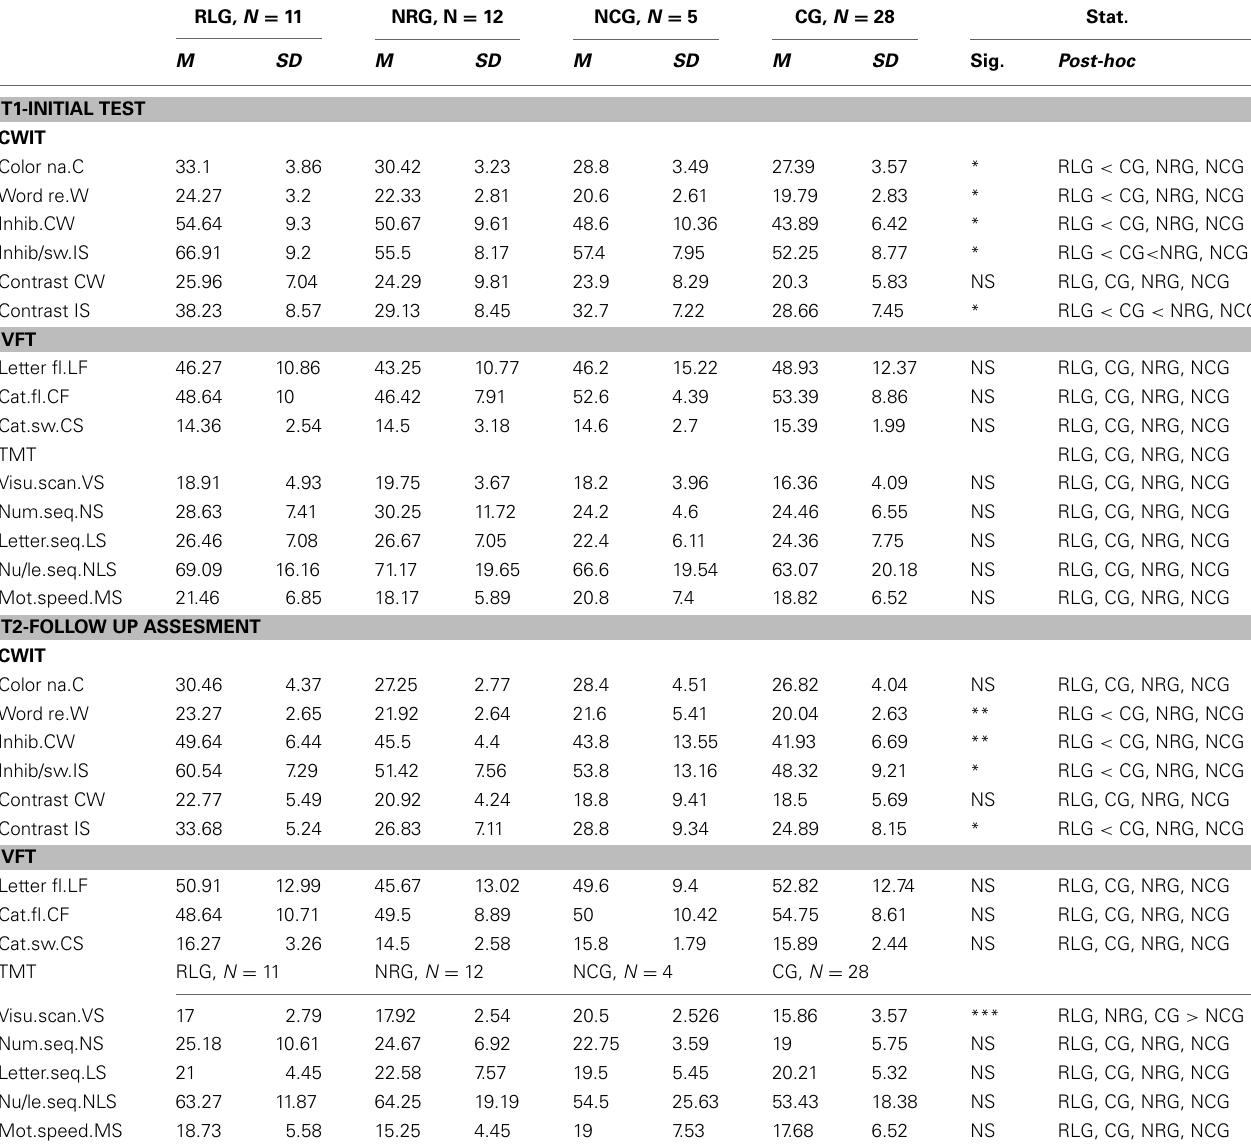
Table 5 | Cognitive performance in the relapse group (RLG), the no-relapse group (NRG), the no change group (NCG) and the control group (CG) at T1 and